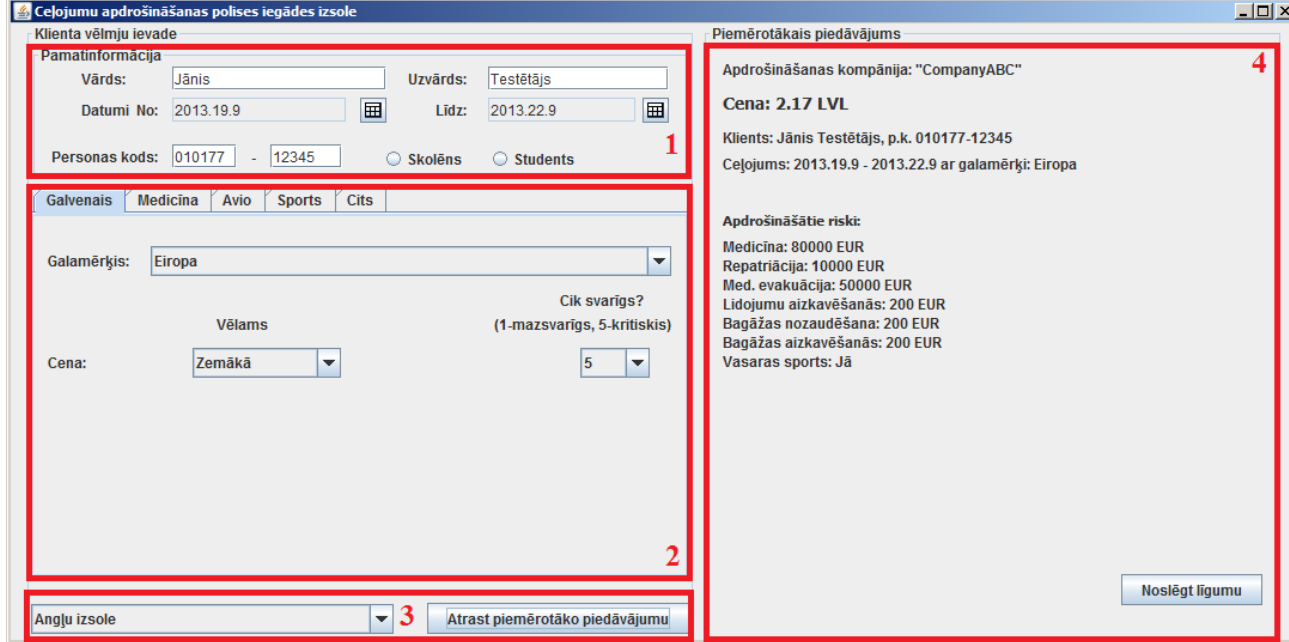
Fig. 6. The interface of the simulation tool.